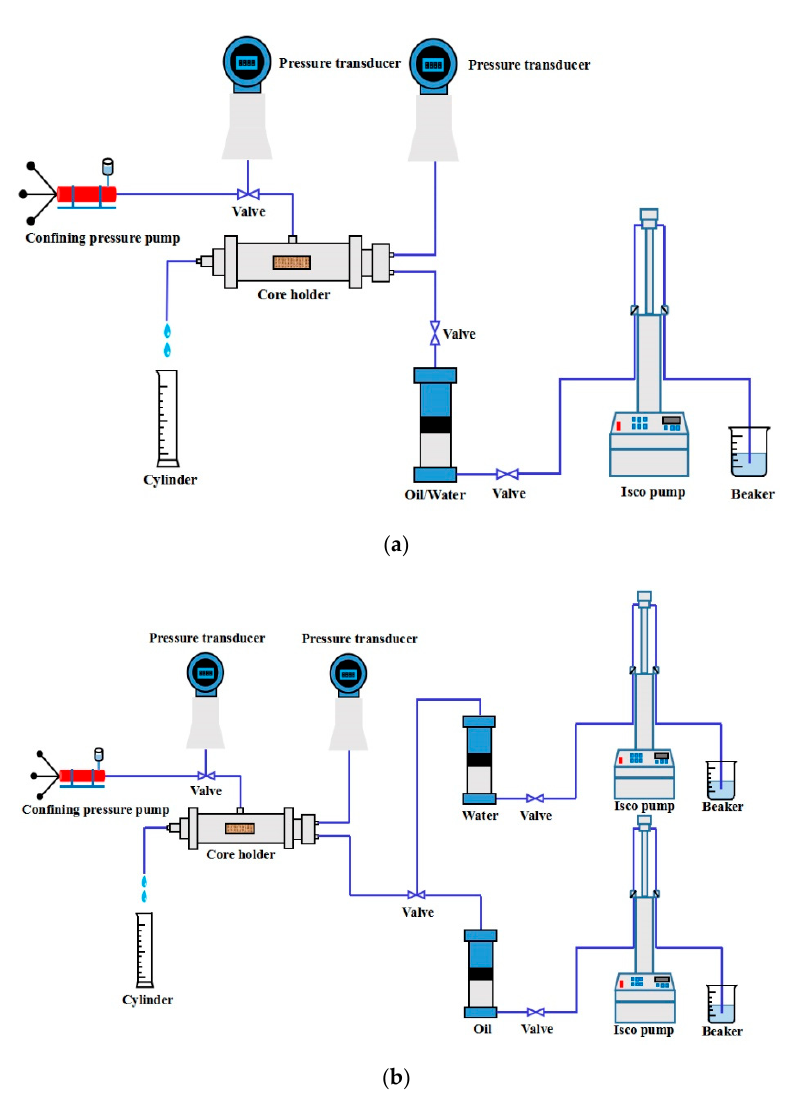
Figure 1. Diagrams of single-phase threshold pressure gradient (TPG) ( a ) and two-phase TPG ( b ) measurement.